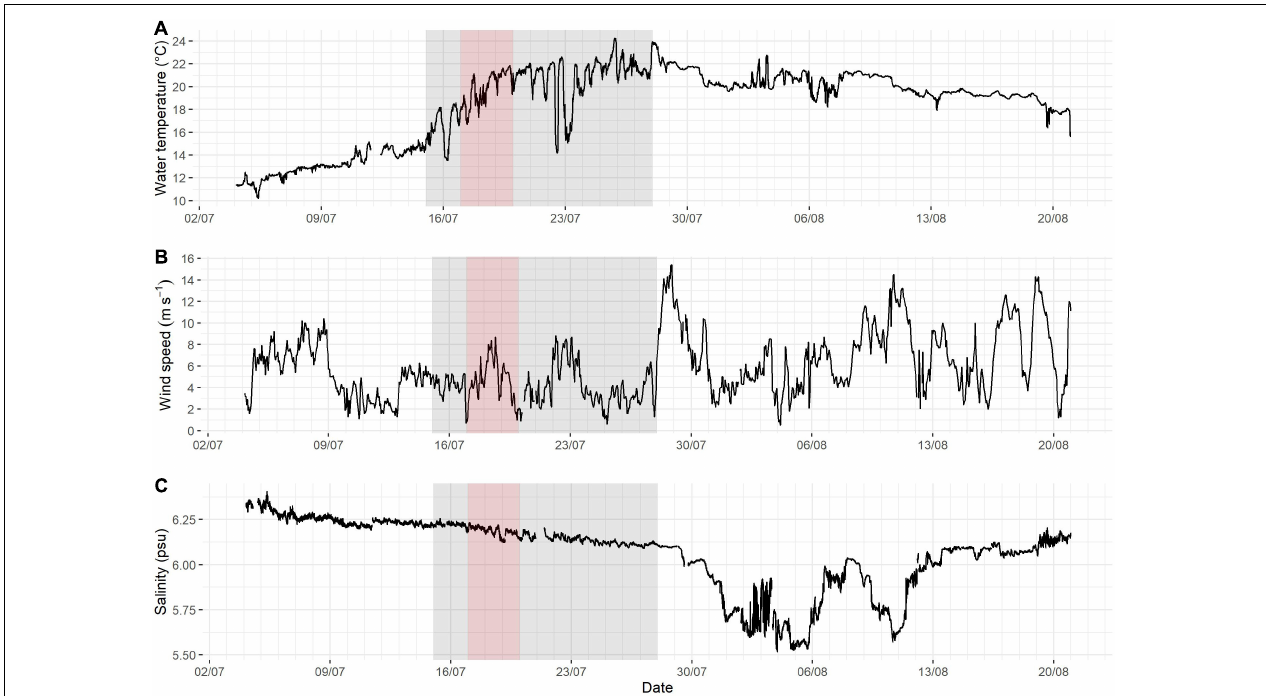
FIGURE 6 | Prevailing environmental conditions, i.e., water temperature (A) , wind speed (B) and salinity (C) , in Utö during summer 2018. The Aphanizomenon and Dolichospermum bloom period (defined here as the days of biomass > approximately 100 µ g L − 1 , see Figure 7 ) highlighted in gray and the bloom peak period (the days with the highest peaks) highlighted in